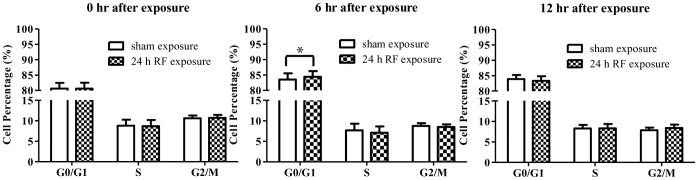
RF-EMF-induced γH2AX foci formation does not change cell cycle distribution in HSF cells.Histograms show the percentages of HSF cells in different phases of the cell cycle at 0 (left), 6 (middle), and 12 h (right) after 24 h exposure to 1800 MHz RF-EMF at 3.0 W/kg. Values represent mean ± SEM of 5 independent experiments. *p<0.05 compared with sham-exposed sample (Student’s t-test).